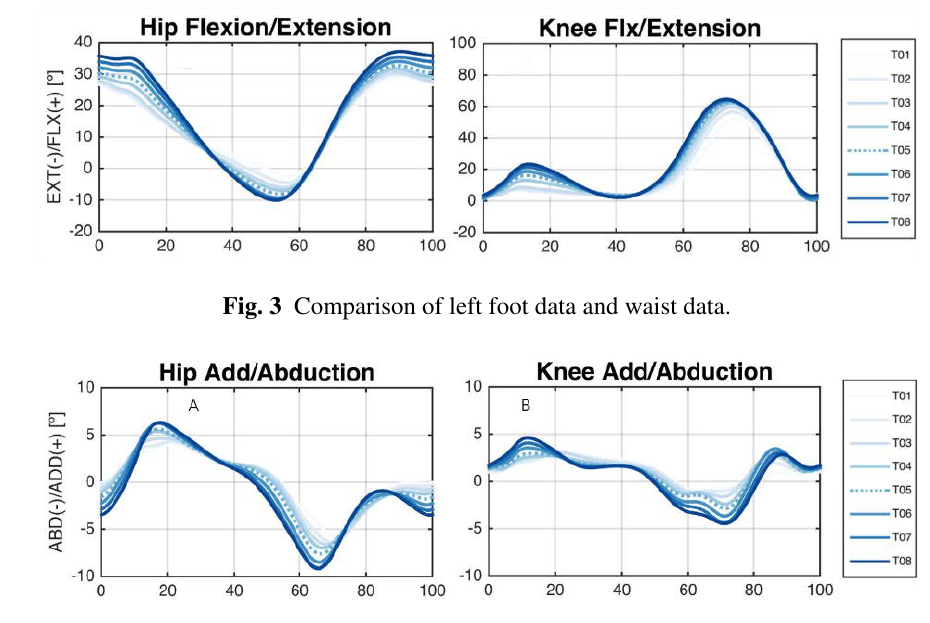
Fig. 4 Period extraction results of a single measurement unit.